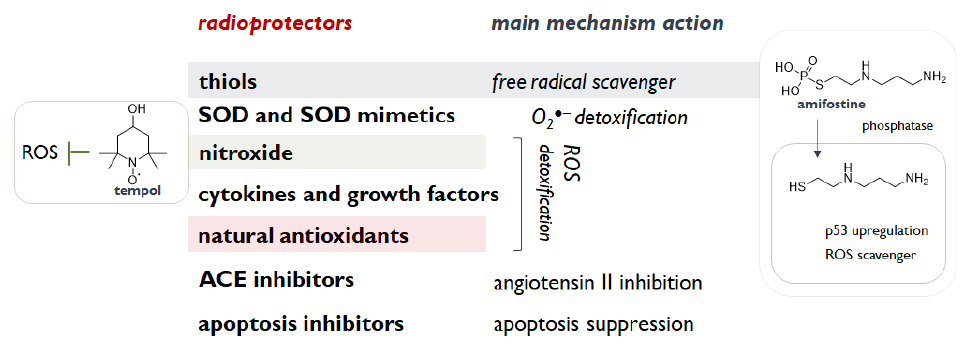
Figure 2. Radioprotectors’ categories and main ascribed mechanisms of action